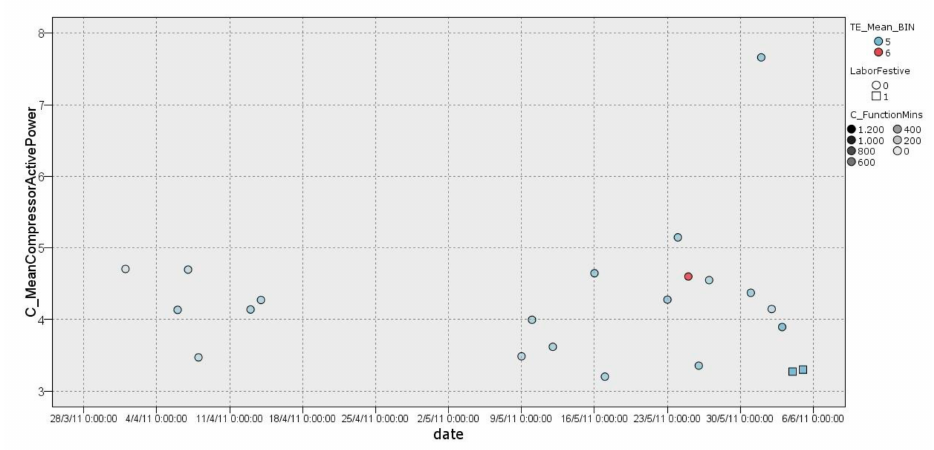
Figure 9. Graphical representation of distribution of cluster 3.2. Cluster 3.3